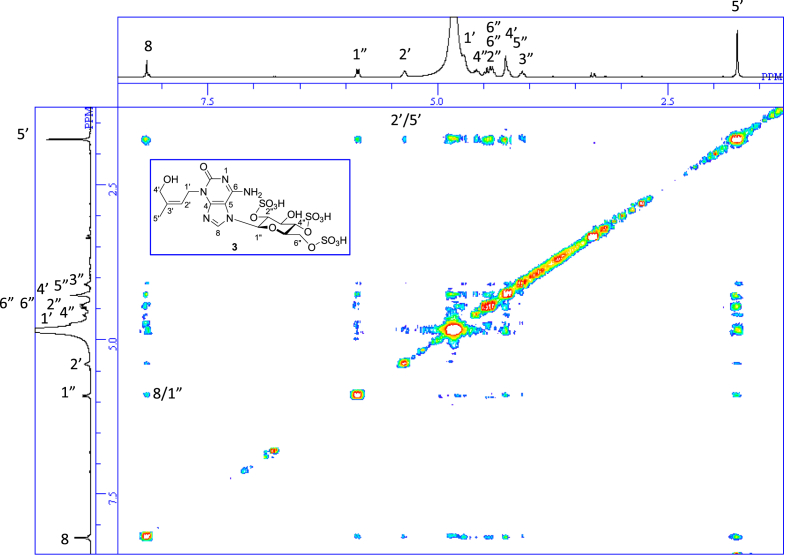
1H–1H NOESY of 3.